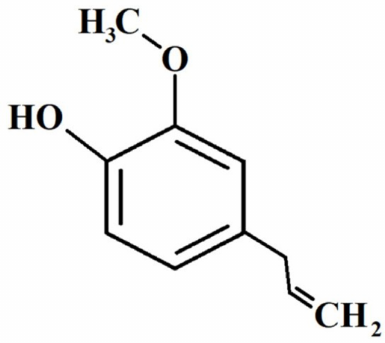
Figure 1. Eugenol’s chemical